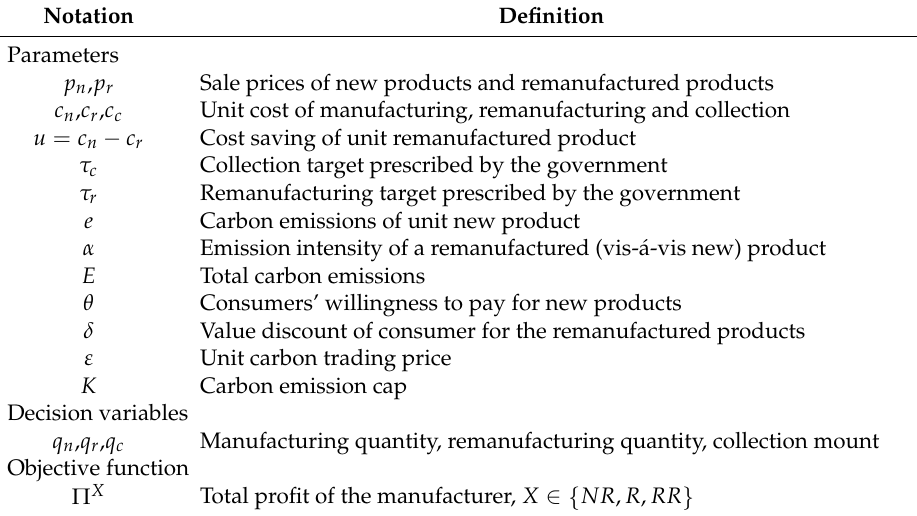
Table 1. The major parameters and